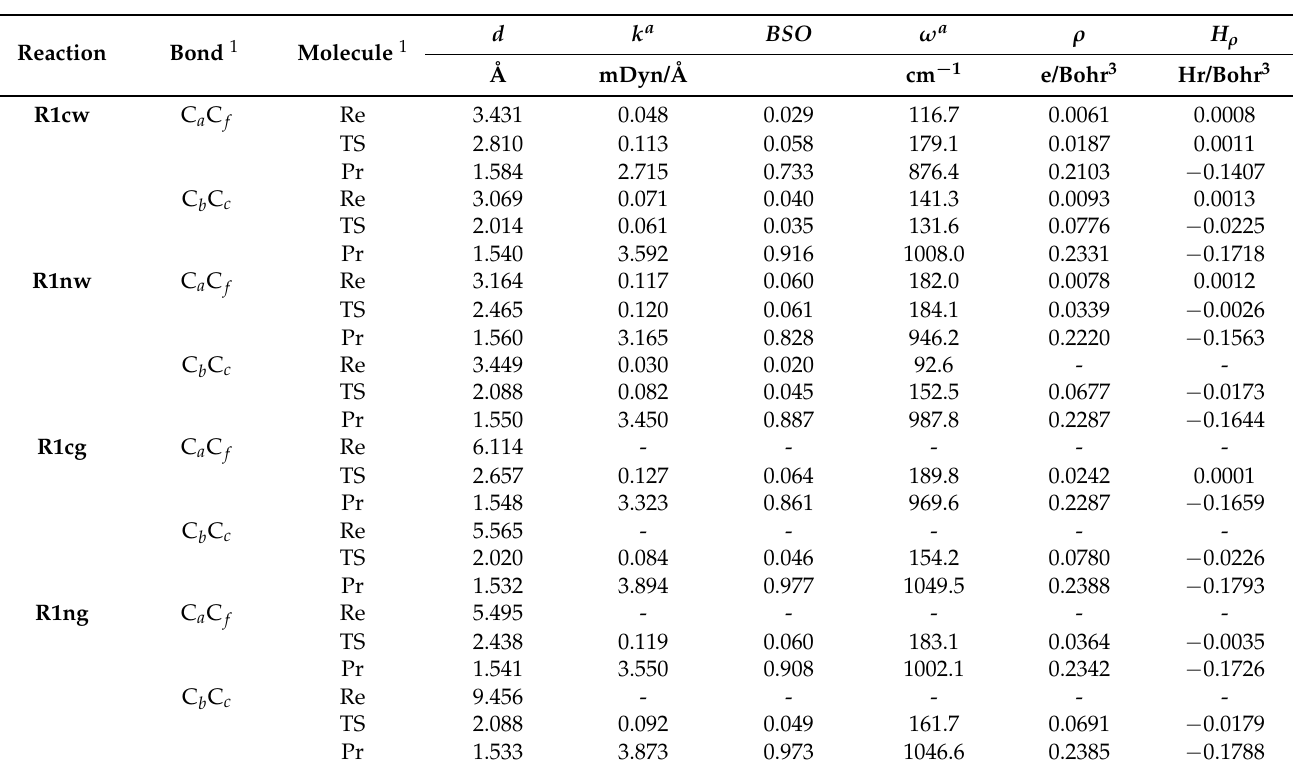
Table 2. The C a C f and C b C c bond length d , the local mode force constant k a , BSO , the local mode frequency ω a , the electron density ρ , and the energy density H ρ at the bond critical point of the stationary points for reaction R1 . B3LYP/6-311+G(2d,p)/AMBER level of theory in water solution, and B3LYP/6-311+G(2d,p) level of theory in the gas